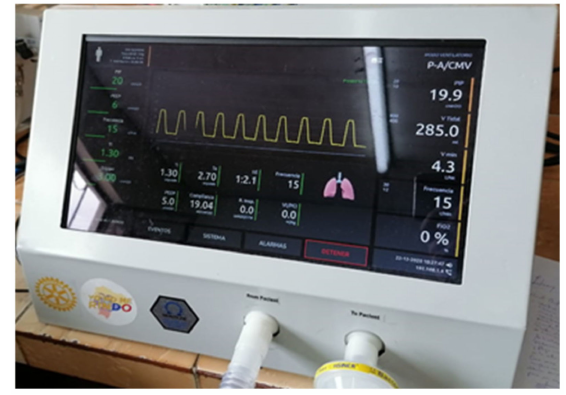
Figure 10. Mechanical ventilator